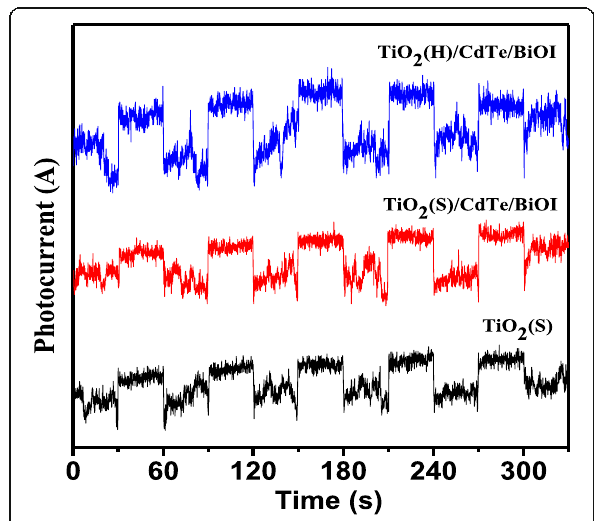
Fig. 10 The transient photocurrent response of TiO 2 (S), TiO 2 (S)/ CdTe/BiOI, and TiO 2 (H)/CdTe/BiOI